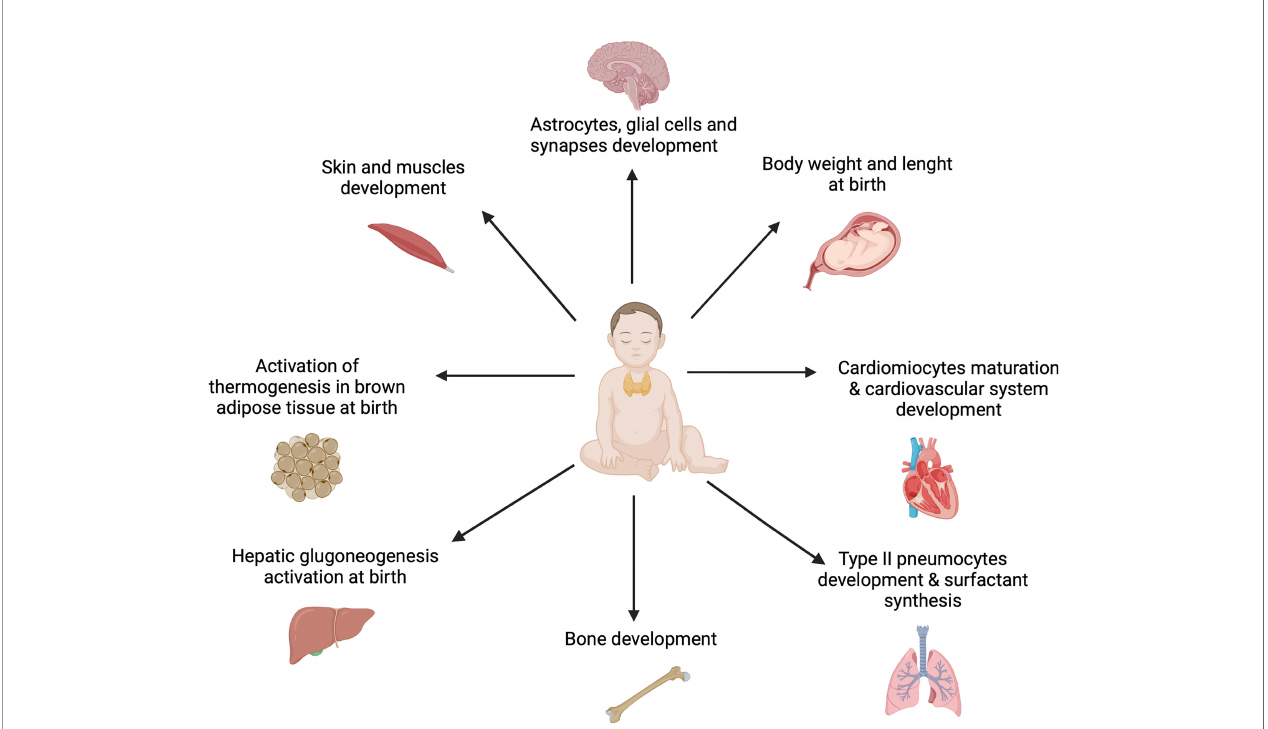
FIGURE 2 | The role of thyroid hormones in fetal and infant development. Thyroid hormones are essential for the general accretion of fetal mass and to provoke developmental events in the fetal brain and somatic tissues from early in gestation. Moreover, they affect the production of other hormones and regulate tissue accretion near term. Furthermore, TH ensure activation of physiological processes as thermogenesis, gluconeogenesis, pulmonary gas exchange and cardiac adaptations at birth (49). Created with